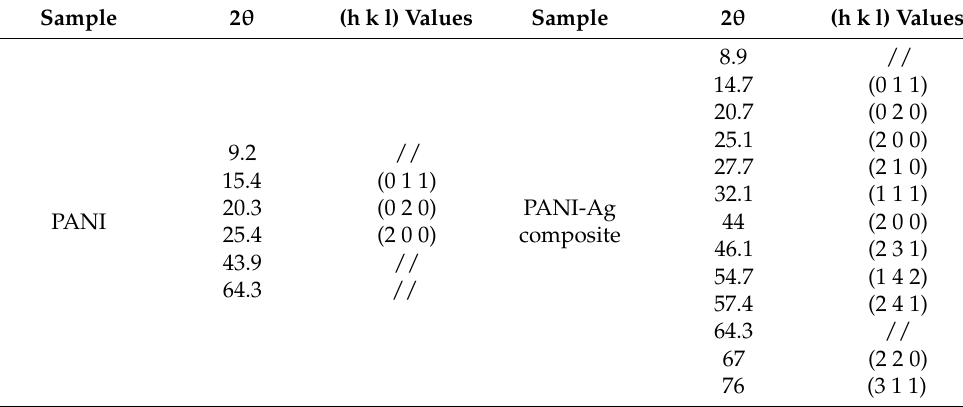
Figure 6. X-ray diffractogram of PANI and the PANI-Ag composite. Table 2. X-ray peaks of PANI and the PANI-Ag composite.